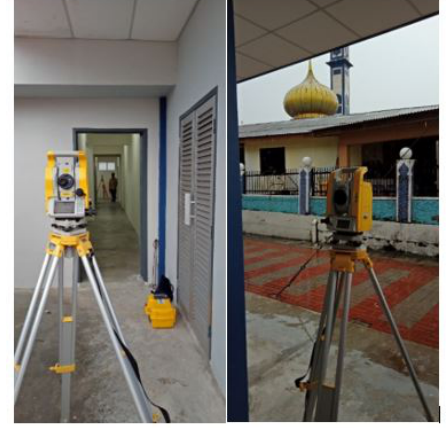
Figure 8. TLS setup